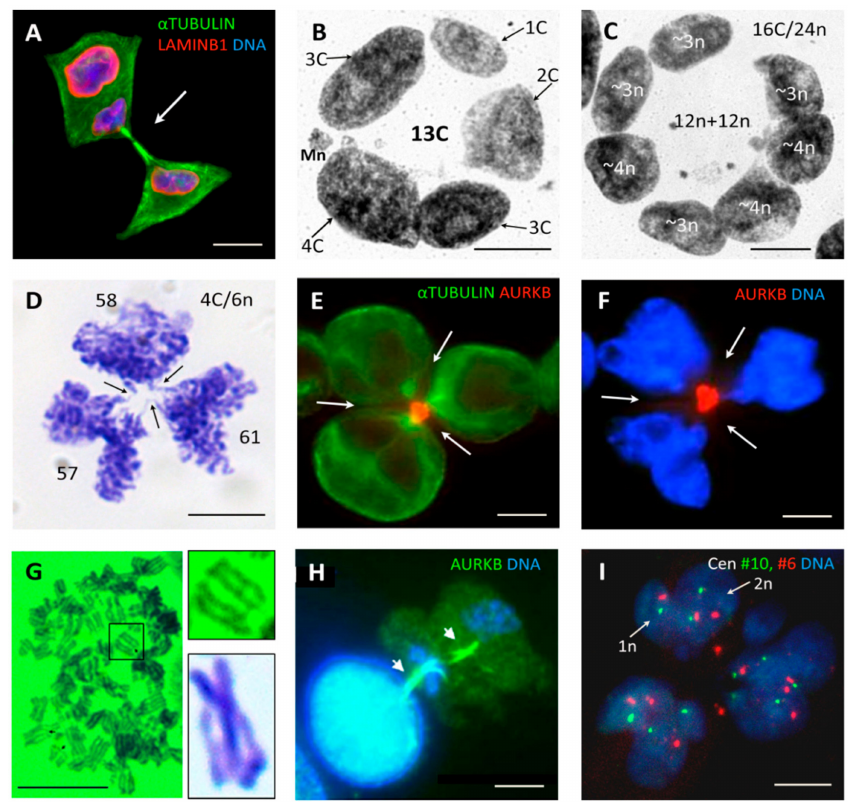
Figure 4. Divisions and multi-nucleation of the genotoxically damaged tumor cells. ( A ) HeLa cell, on day two post-irradiation (10 Gy): One subnucleus in a bi-nucleated cell is being divided (arrow). ( B ) A processed for image analysis (DNA bridges were deleted) multinucleated giant HeLa cell nucleus on day six post-irradiation containing sub-nuclei with even and odd proportions of DNA content, along which a near-haploid (~1C) sub-nucleus and a micronucleus (Mn) were seen; ( C ) A processed for image analysis (DNA bridges were deleted) multinucleated giant HeLa cell on day nine post-irradiation containing four ~3n and three ~4n sub-nuclei with a similar sum DNA content; ( D ) The anaphase of the multipolar mitosis of an irradiated HeLa cell with chromosome bridges between the karyokinesis products of three bilobed groups, a finding indicative of the pair-wise fusion of segregated neighboring genomes (stained with toluidine blue for DNA). The arrows show indentations in the bridges between these pairwise fused products of three karyotomies due to incomplete or ongoing cleavage by radial cytotomy; ( E , F ) Radial cleavage furrows bringing three Aurora KB-positive mid-bodies to the fused one of their spindle poles together, potentially segregating the progeny with pedogamically fused bilobed nuclei; ( G ) The diplochromosomic metaphase of a HeLa cell on day five post-irradiation (10 Gy) (stained with Toluidine blue for DNA), resembling the diakinetic stage of meiosis with often intertwisted or DNA-bridged (arrows) two pairs of cohesed sisters. On insert enlarged: (a) The enframed bridged diplochromosome and an example of the chiasma found between diplochromosomes of the irradiated Namalwa cell line; ( H ) Two subsequent divisions of the tetraploid sub-nucleus of a giant Namalwa cell to a haploid pair of nuclei on day five post-irradiation (10 Gy) are seen, displaying two persisting mid-bodies (shown by the arrows). Persistence of two subsequent mid-bodies and ~ haploidy in DNA content of the final anaphase figures suggest that the second division closely followed the first division, omitting the S-phase. This sample was collected after 2-h treatment with the proteasome inhibitor—lactacystin; The brightness in the DAPI channel was enhanced to highlight small nuclei of the second anaphase; ( I ) The FISH sample for centromeres #6 and #10 of HeLa cells on day four post-irradiation (10 Gy) shows (arrows) haploid (monosomic) and diploid (disomic) lobes of a sub-nucleus resulting after multipolar karyokinesis. Bars = 10 µ m. Figure 4A–C,H are reproduced from [78], with permission of the